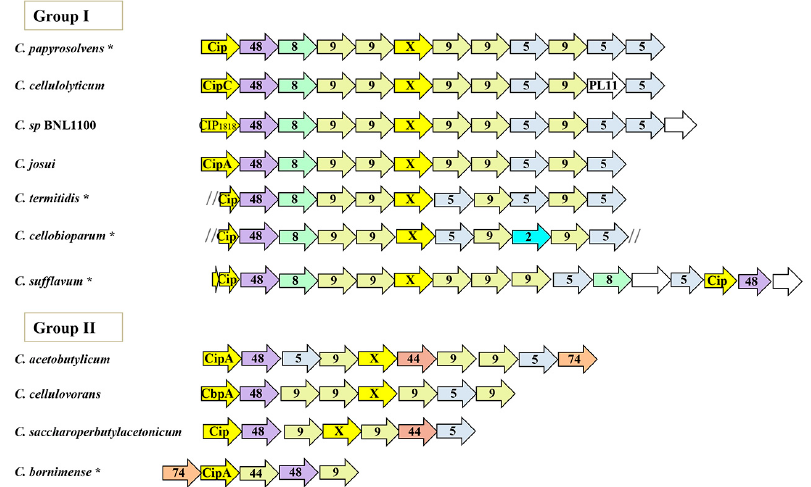
Figure 1. Similar and modular organization of the cellulosomal gene clusters ( sca ) of mesophiles. Schematic representation of the gene cluster harboring the major scaffoldin, and followed by genes coding for dockerin-containing cellulolytic enzyme, which are organized in a similar sequence along the gene cluster of the marked species. The major scaffoldin gene is represented by cip ; numbers denote the family of glycoside hydrolases; X stands for the orfX gene; asterisks (*) mark draft genomes that have more than two contigs; slashes (//) indicate that the ORF may not be complete, because it was located at the end of contig.